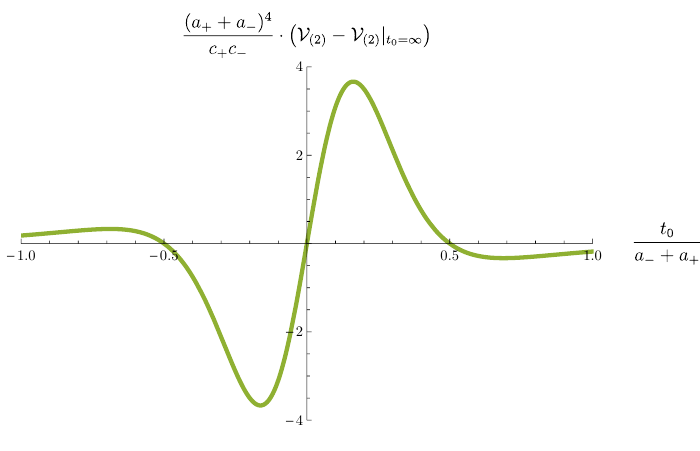
Figure 5 . V (^ g + ; ^ g (cid:0) ) for example (2) ; mixed